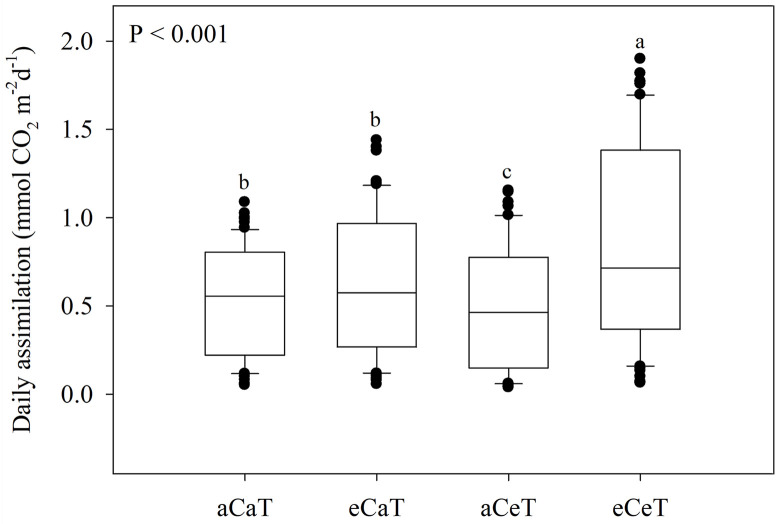
Comparison of daily canopy net photosynthesis levels from 25 DAE to 64 DAE for potato plants grown under four different conditions of CO2 and temperature.Means labeled with different letters differ significantly at P < 0.05.